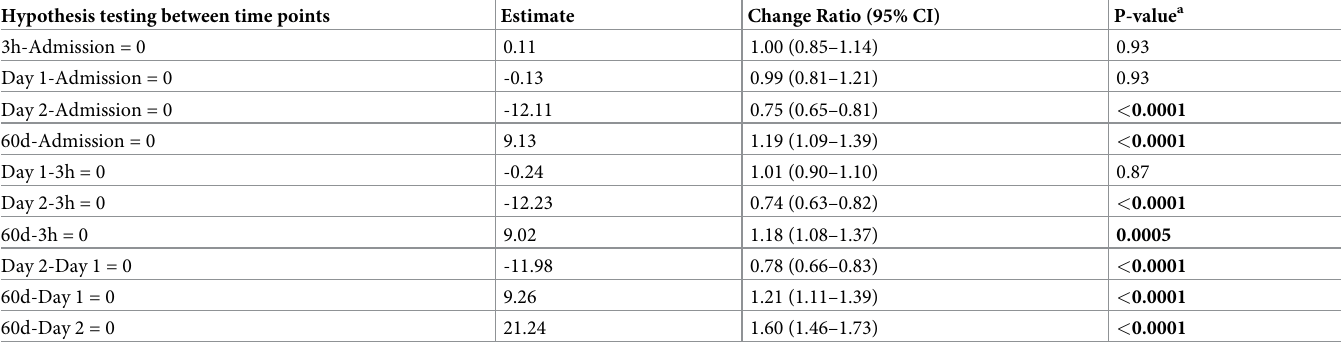
Table 3. Model estimates of total PC levels and the corresponding ratios of change between the sampling time points.